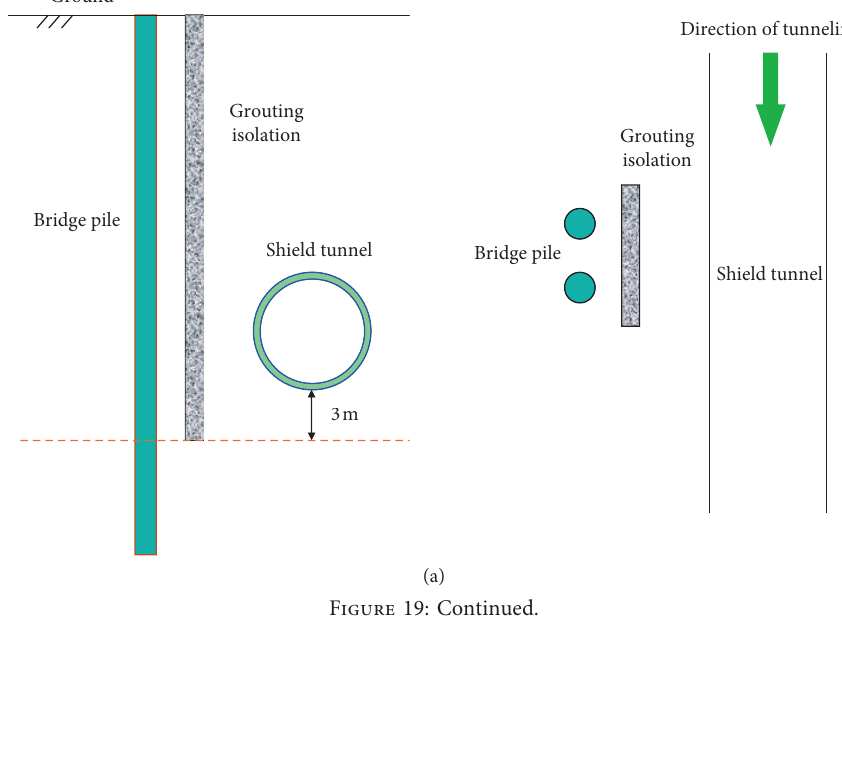
Figure 18: Longitudinal displacement of the pile along the tunnel: (a) 6 rings after passing the pile; (b) 8 rings after passing the pile.